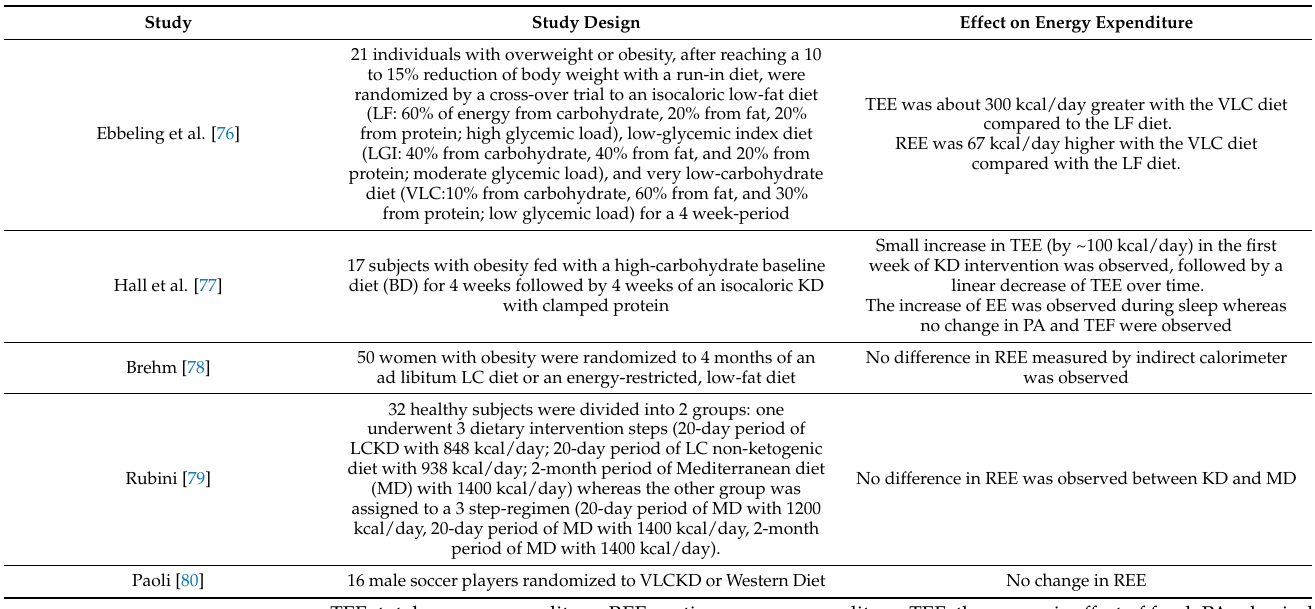
Table 1. Clinical trials investigating the effect of KD on energy